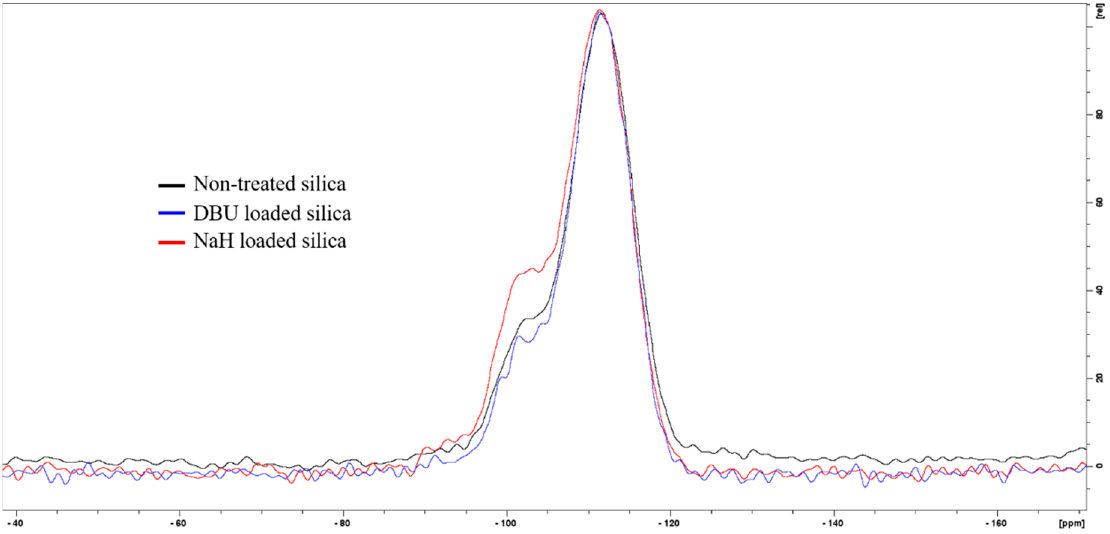
Figure 2. 29 Si ssNMR of untreated silica (black), DBU − loaded silica (blue), and NaH − loaded silica (red).